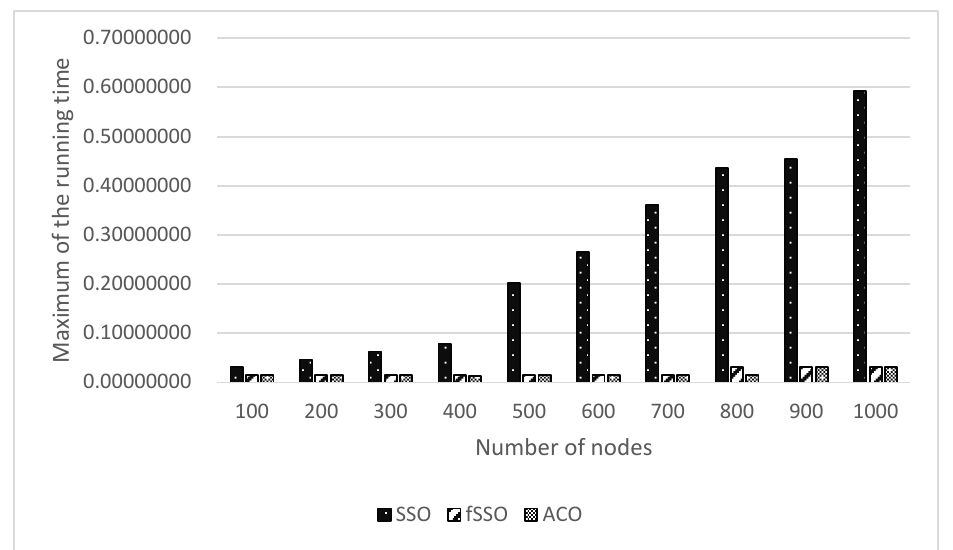
Figure 12. Maximum of the running time for ten benchmarks. Table 16. Minimum of running time of fSSO compared with SSO and ACO for ten